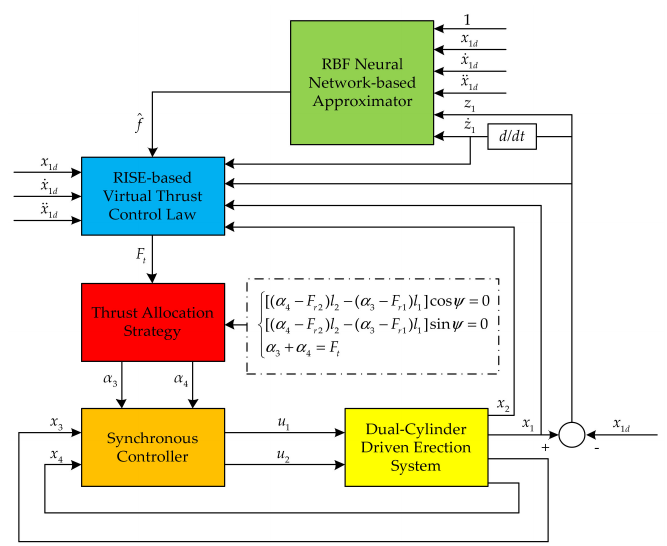
Figure 9. Schematic diagram of the proposed synchronous control